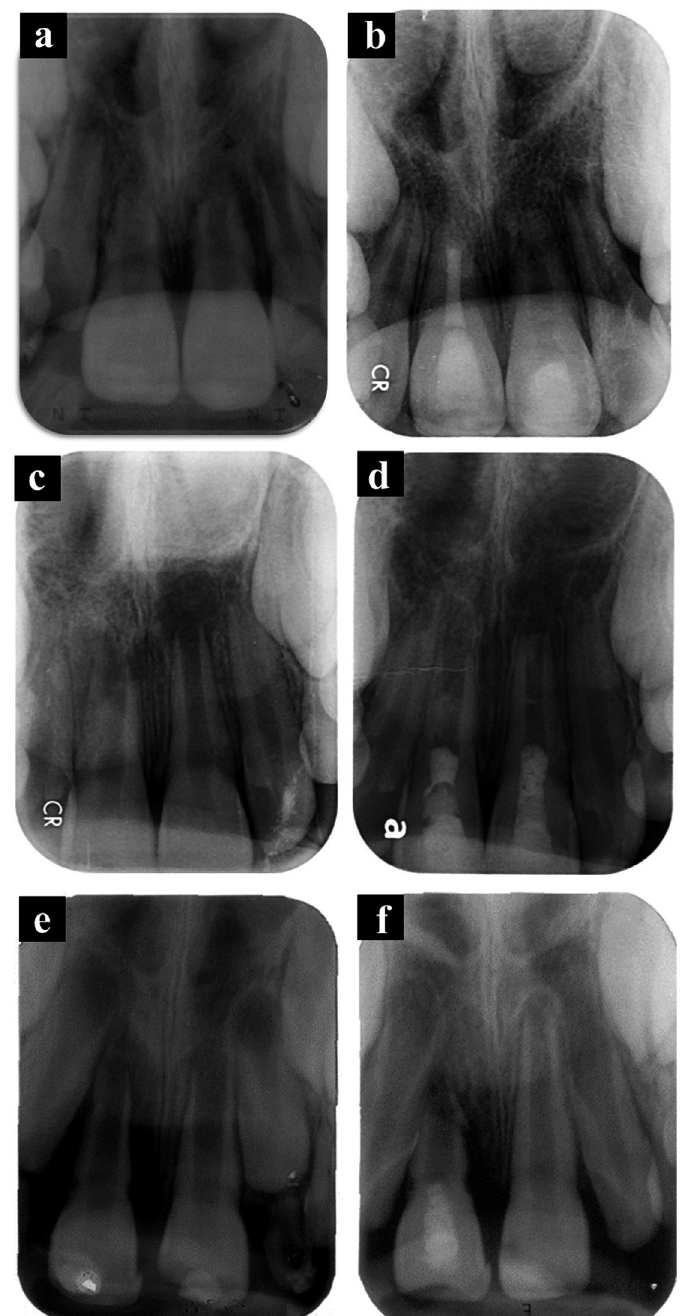
Figure 3- (a) Initial radiography of a 9-year old girl with extrusive luxation of the maxillary left central incisor after a fall; (b) After 24 months, showing continued root development. (c) Initial radiography of a 9-year old boy with extrusive luxation of the right and left maxillary central incisors after sports activity. This radiography showed signs of root resorption. This patient took 3 years to seek treatment in the dental trauma service, after receiving initial care in a hospital; (d) After 18 months, showing periapical healing, incomplete apical